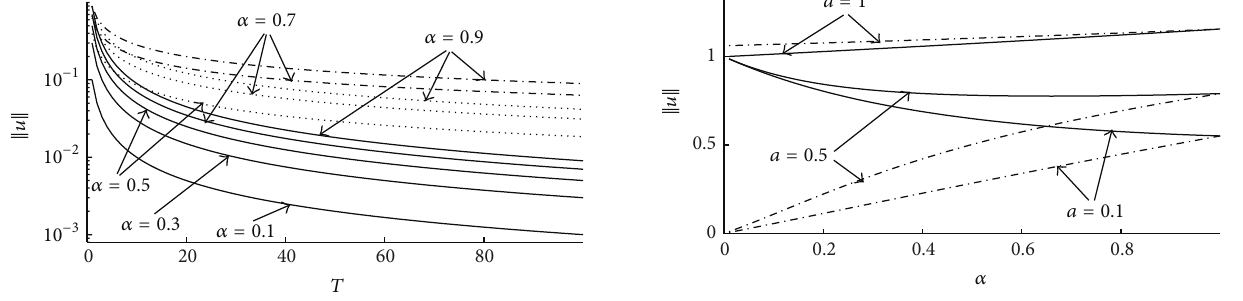
Figure 4: The dependencies for norm of control from 𝑇 . Logarith- mic scale used for ordinates.